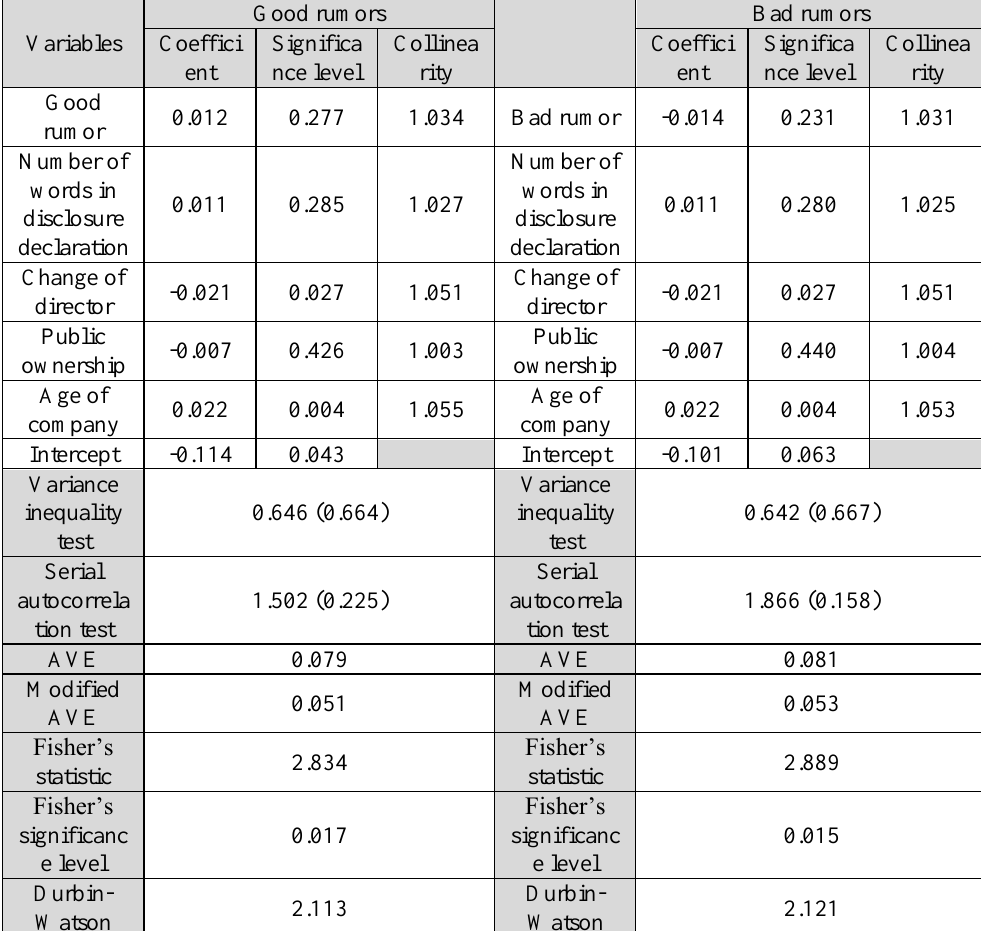
Table 5: Final estimation of the regressive model in the first major hypothesis (Good and bad rumors with abnormal return)